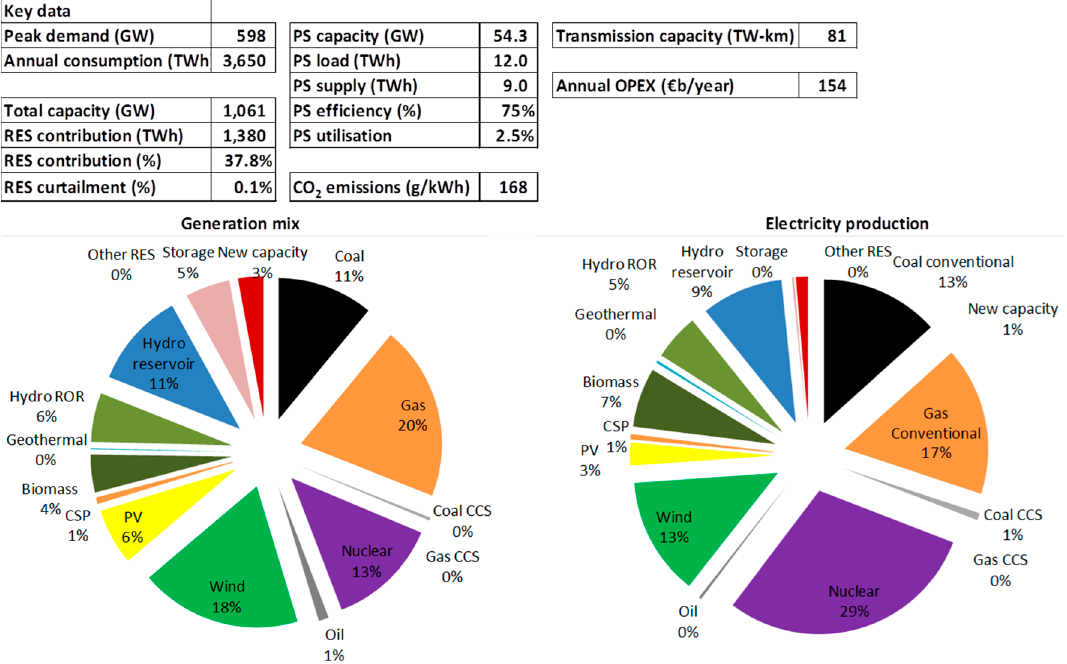
Figure A1. Low renewable energy resources (RES) scenario for 2020.